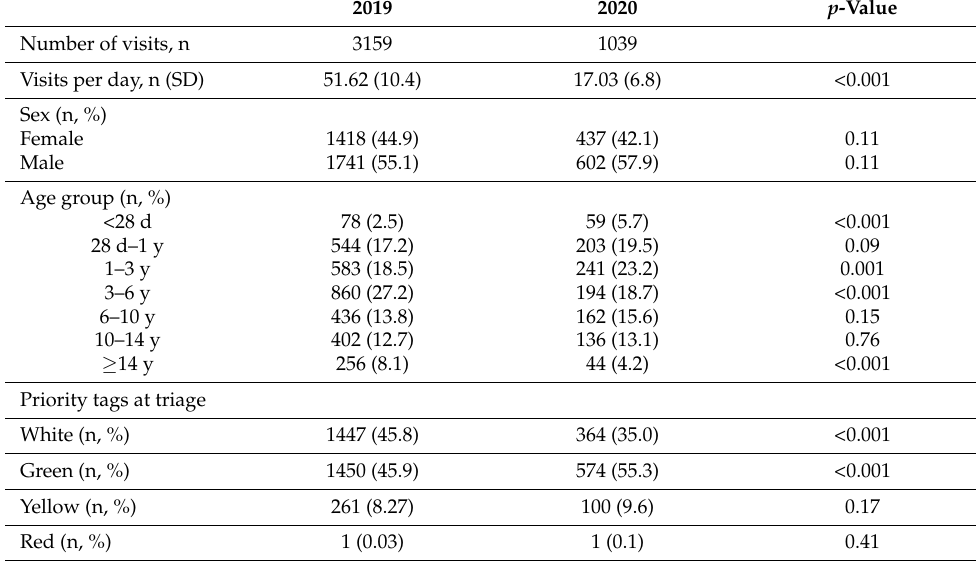
Table 1. Demographic characteristics and triage code severity of the pediatric emergency department visits in March–April 2019 (non-COVID-19 period) compared with the same period in 2020 (COVID- 19 period). (d = days; y =